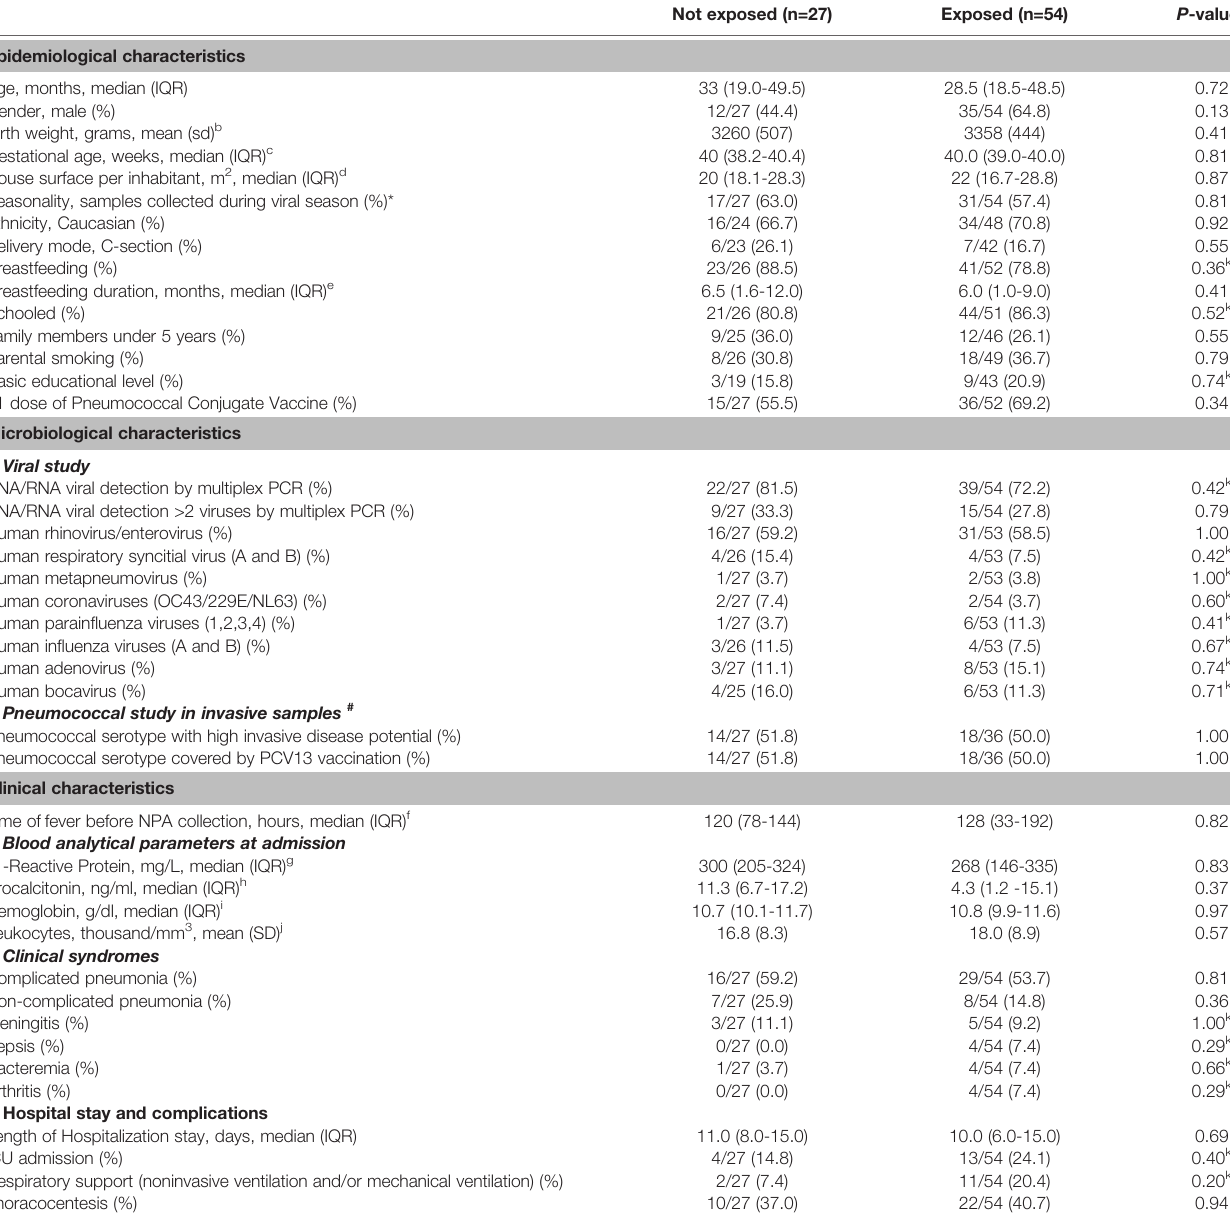
TABLE 1 | Epidemiological, microbiological, and clinical characteristics of the study